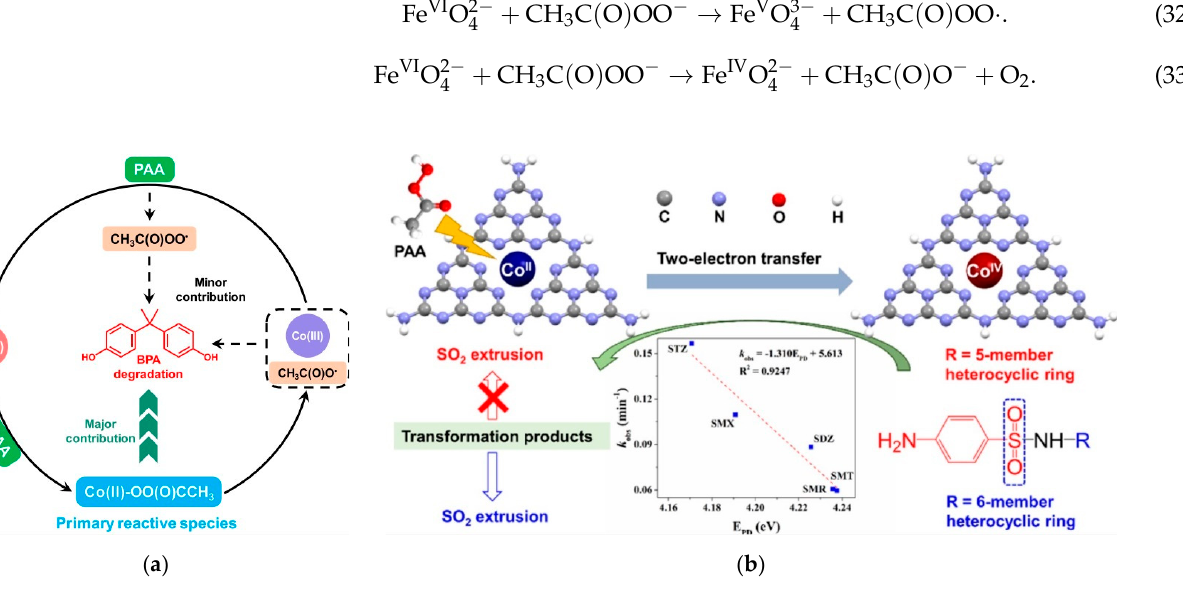
Figure 5. Non-radical pathway of Co (II)-PAA. Reprinted with permission from Ref. [68]. 2021, Zihao Zhao, Xinhong Li, Hongchao Li, Jieshu Qian, Bingcai Pan. ( a ), Co (II)-doped g-C 3 N 4 -PAA. Reprinted with permission from Ref. [44]. 2021, Banghai Liu, Wanqian Guo, Wenrui Jia, Huazhe Wang, Qishi Si, Qi Zhao, Haichao Luo, Jin Jiang, and Nanqi Ren. ( b ) process.